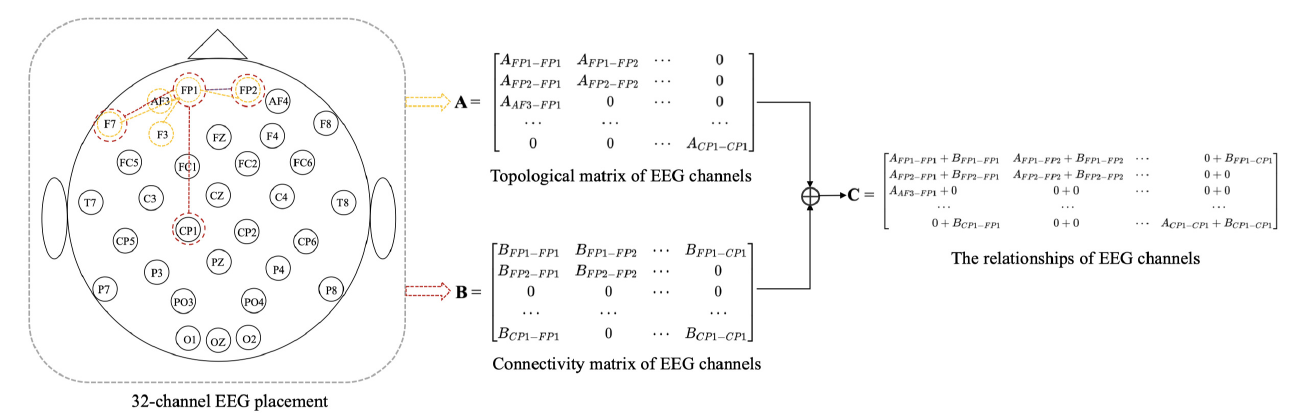
Figure 2. Two-dimensional placement for 32-channel EEG and adjacency matrix construction. (1) Topological matrix of EEG channels. The construction of the adjacency